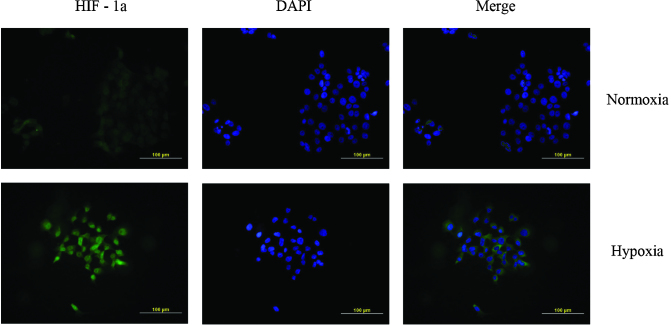
HIF-1α expression detected by immunofluorescence staining after hypoxia for 48 h (scale bar, 100 µm). Cells cultured under hypoxia showed higher HIF-1α expression. HIF, hypoxia-inducible factor.